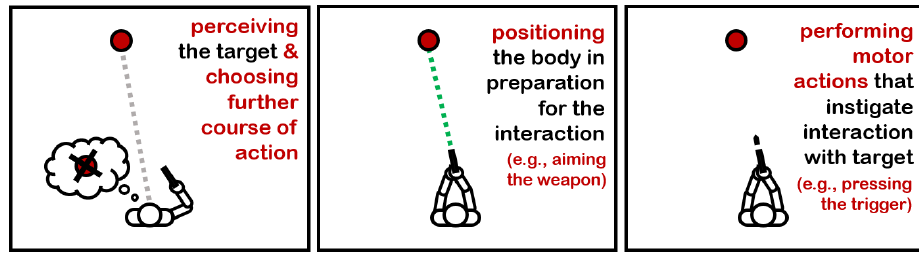
Figure 5. The multi-stage process of performing core interaction